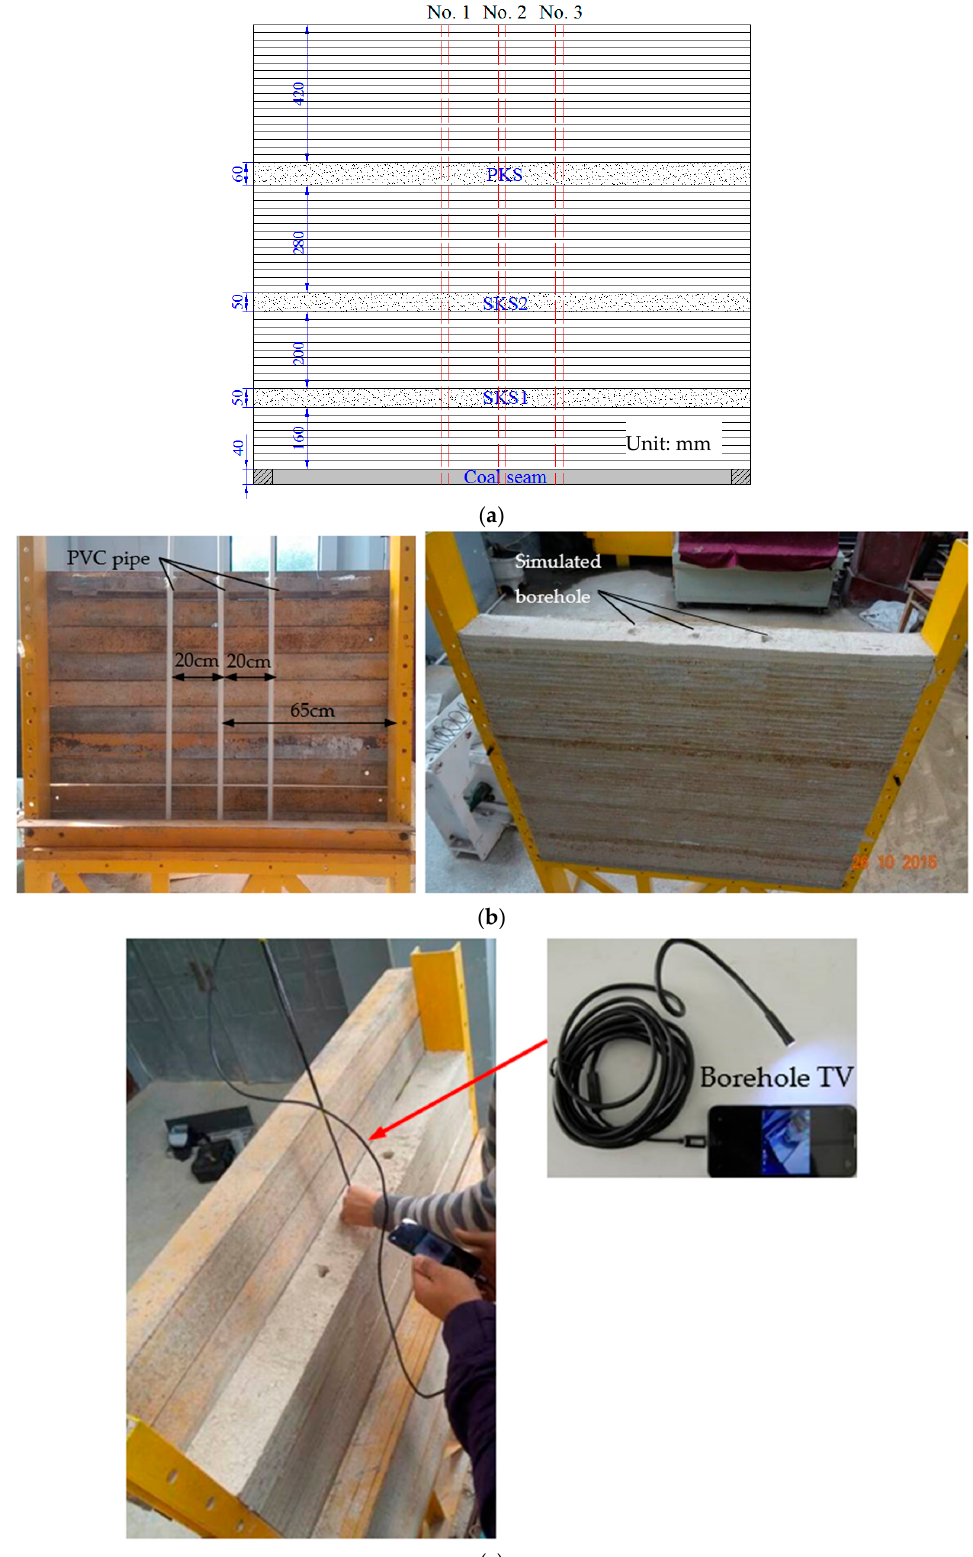
Figure 7. Simulation experiment model and borehole observation method. ( a ) Design of simulation experimentmodel; ( b )Formationofthesimulatedborehole; ( c